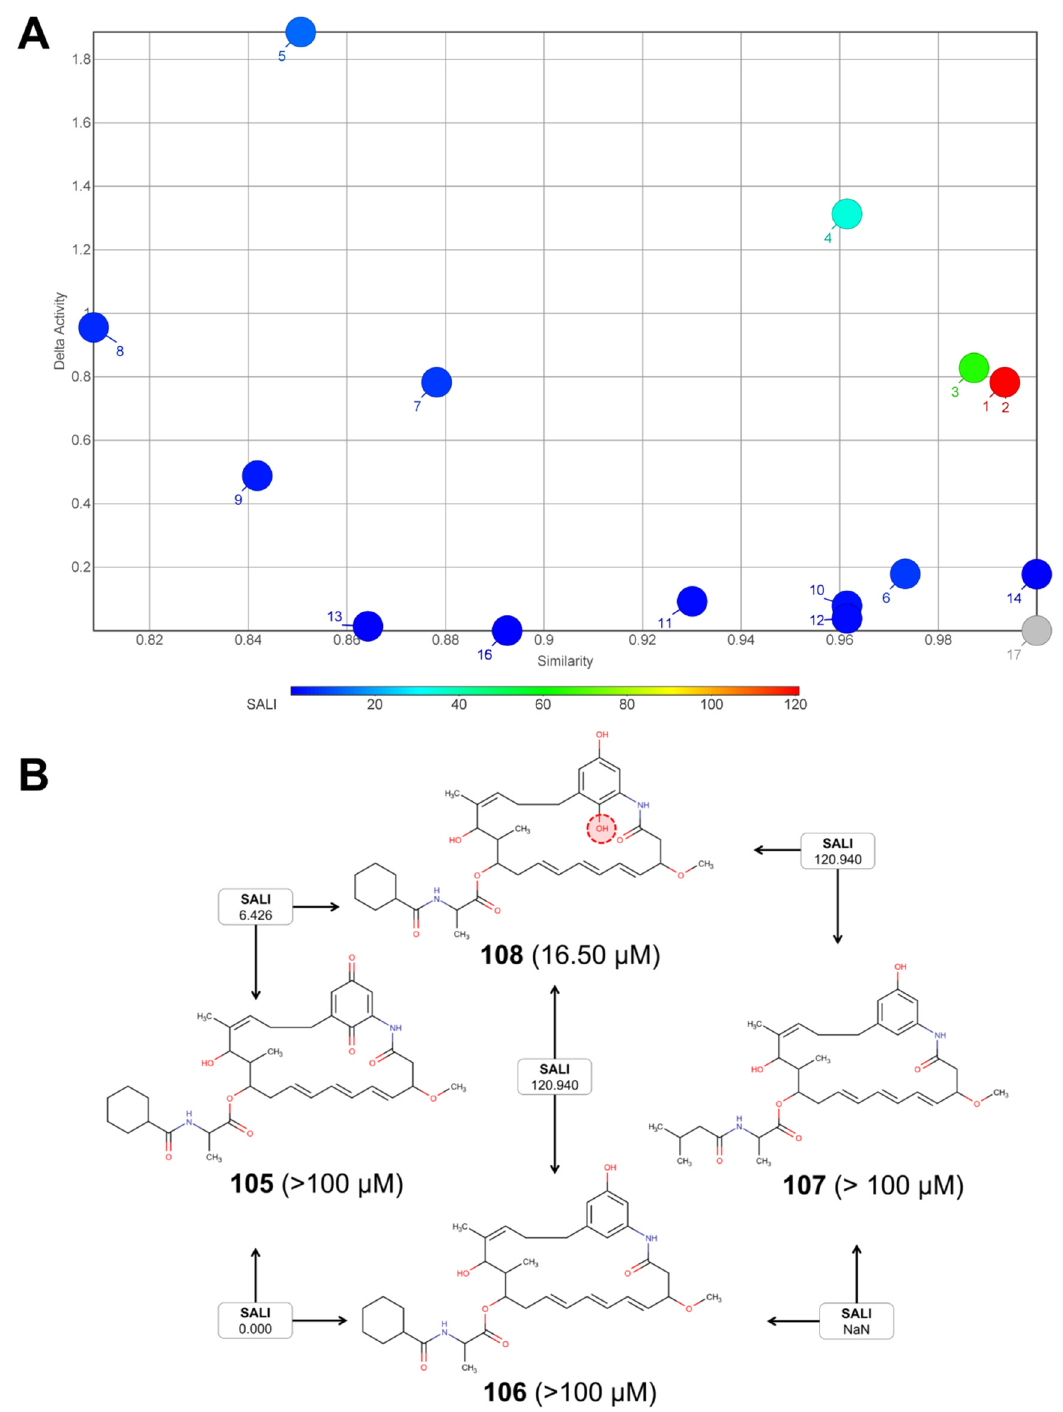
Figure 11. Pairs of structurally related compounds showing activity cliffs. A SALI analysis performed by DataWarrior identifies 17 metabolite pairs with activity cliffs. ( A ) For each pair of compounds, the delta of activity was plotted versus the similarity. The color scale bar indicates the SALI value from 0 (blue) to 120 (red). Each numbered label shows the pair of structurally related compounds listed in Table 5. ( B ) Structures and SALI values for selected compounds (i.e., 105 , 106 , 107 and 108 comprising the pair numbers 1, 2, 7, 15, 16 and 17). The values in parentheses indicate the IC 50 experimentally calculated for each compound. Compound 108 differs from 105 , 106 and 107 in the additional hydroxyl group at the aromatic ring (highlighted by the red dotted circle).